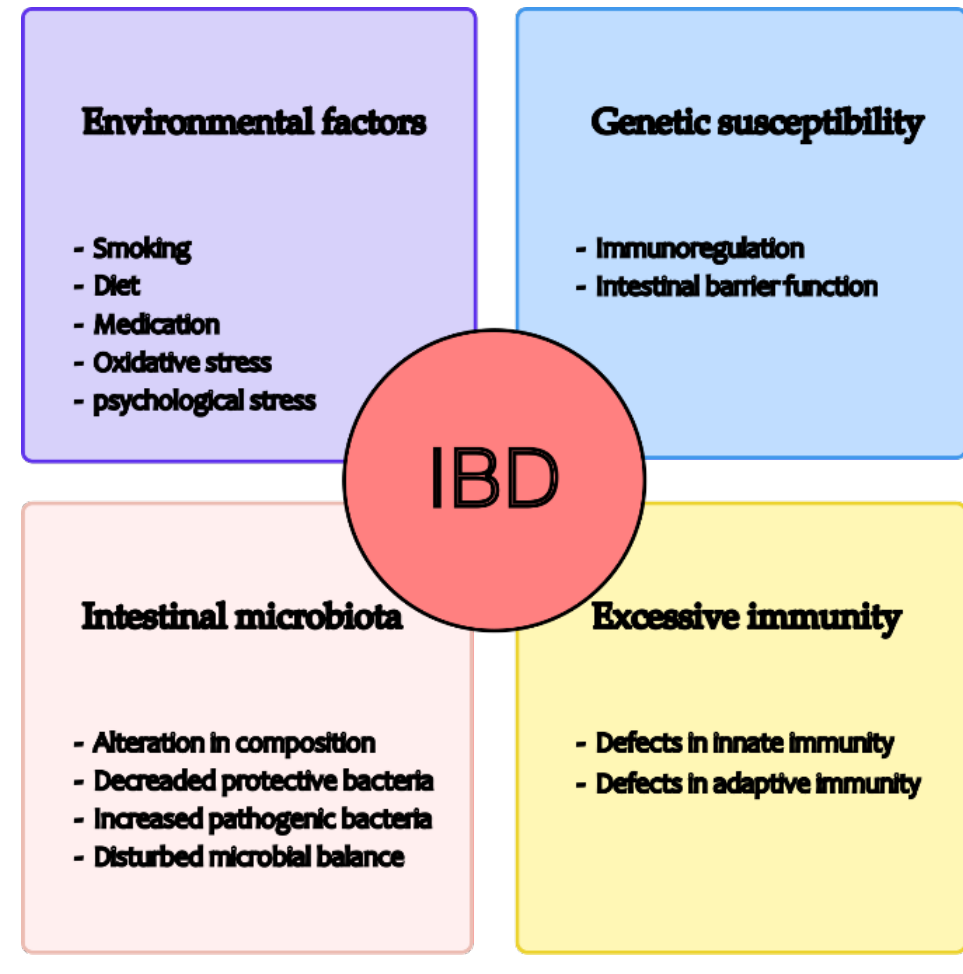
Figure 1. Possible causes of IBD development.